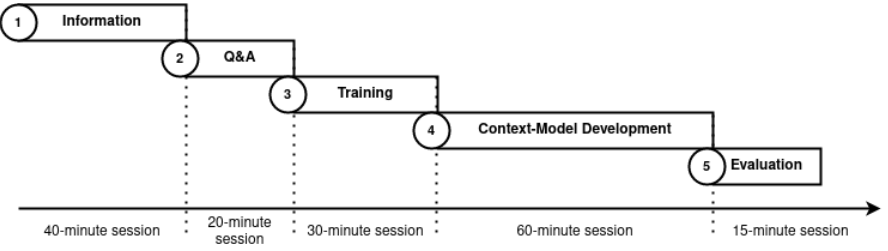
Figure 5. Process for training evaluators and data